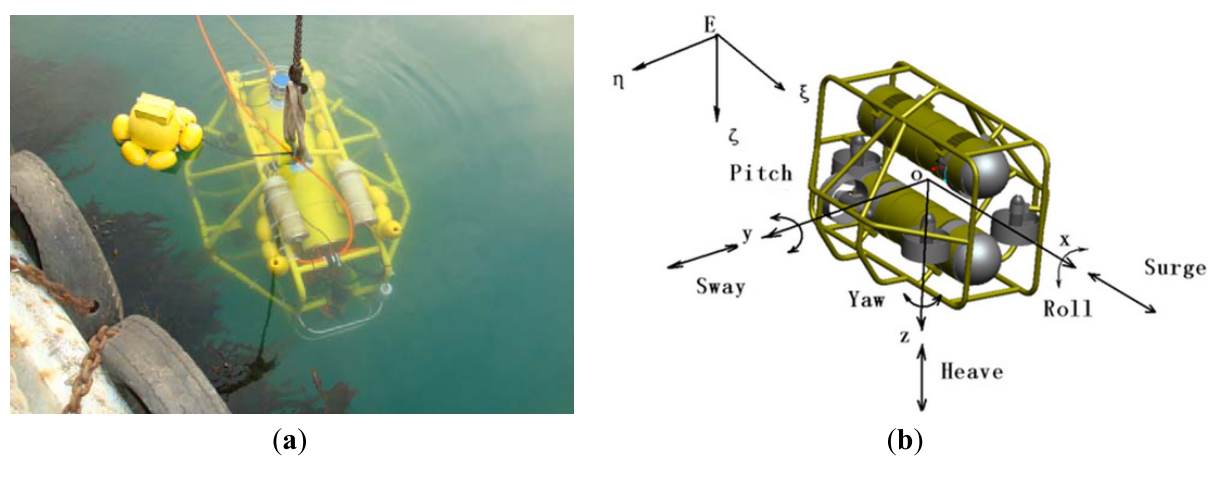
Figure 2. Control architecture of the C-Ranger